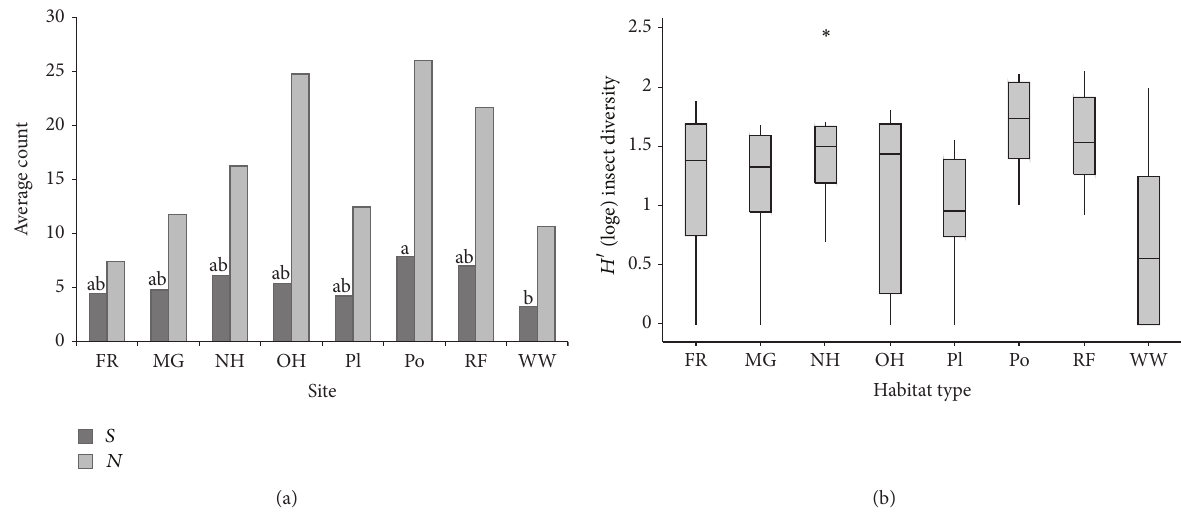
Figure 1: Response of insects to site. (a) Mean count for number of species ( 𝑆 ) and abundance ( 𝑁 ). Letters represent significant differences between sites following Tukey comparisons (b) Whiskered Box Plot showing the range of diversity scores. Box indicates median value and lower and upper quartiles. Whiskers indicate the range. Outliers indicated by an asterisk. Flower Rich Grassland (FR), Mown Grassland (MG), New Hedge (NH), Old Hedge (OH), Plantation Woodland (Pl), Pond (Po), Ridge (RF) and Furrow Grassland, and Woodhorn Woodland